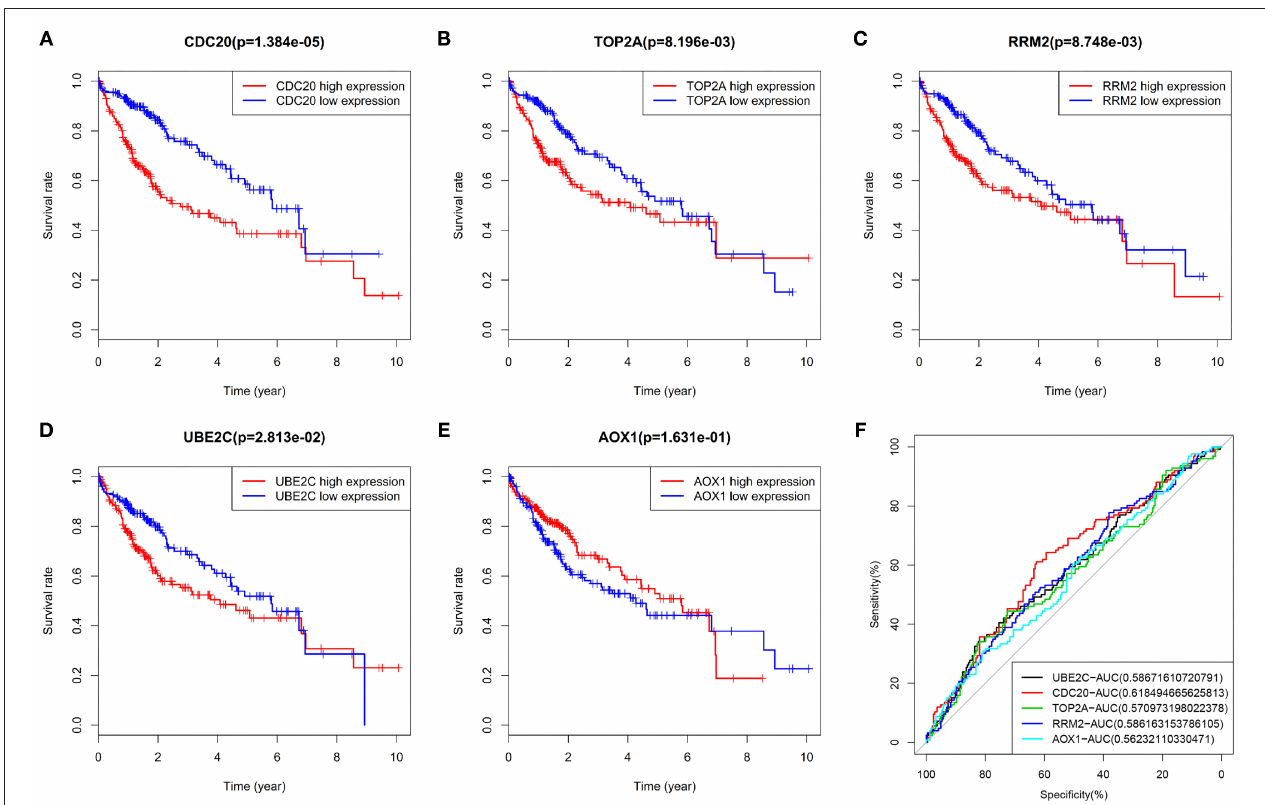
FIGURE 7 | Survival analysis and ROC curve of five core genes in TCGA-LIHC cohort. (A), The survival curve of CDC20 in HCC. (B) , The survival curve of TOP2A in HCC. (C), The survival curve of RRM in HCC. (D) , The survival curve of UBE2C in HCC. (E), The survival curve of AOX1 in HCC. The X-axis indicates survival time (years), and the Y-axis indicates survival rate. p value is shown in the header. Red indicates high gene expression, and blue indicates low gene expression. (F) , AUC values of five genes were calculated separately, and ROC curves were drawn. In the figure, the five genes are represented by different colors, and the color code and AUC values are shown at the bottom